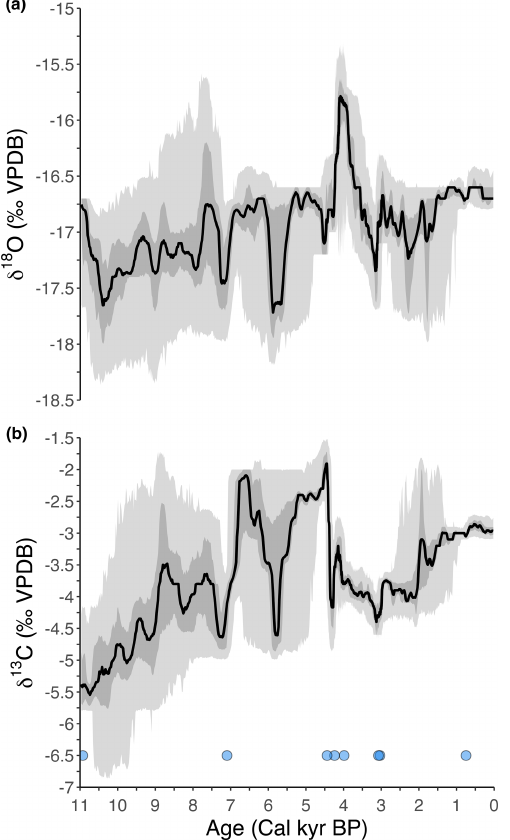
Figure 5. δ 18 O carb (a) and δ 13 C carb (b) from Highway 130 Lake. The black line represents the median estimate of the ensemble re- gression, and the dark and light gray bands show the 50% and 95% highest-probability density regions, respectively. The blue dots in- dicate the calibrated radiocarbon ages used for the age–depth model (refer to Table 2 for calibrated age uncertainties).